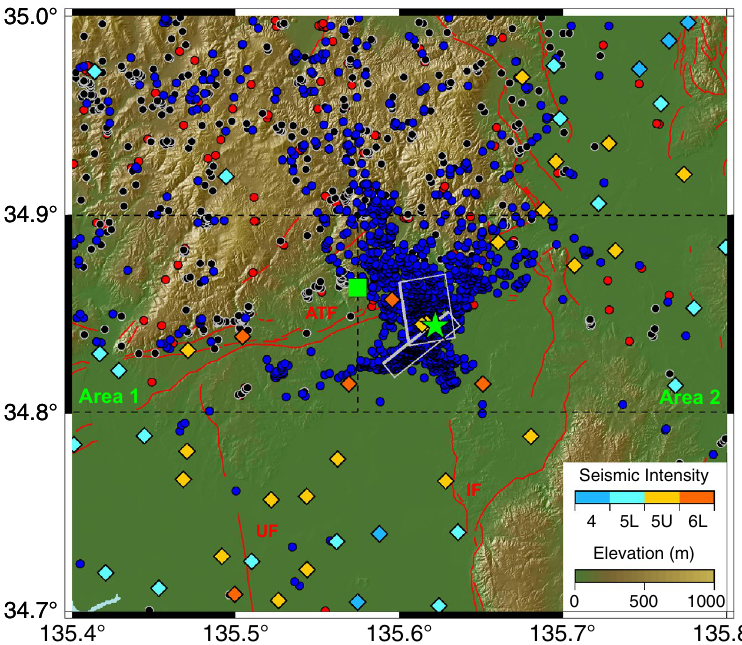
Figure 1. Map of the seismic sequence of the 2018 Northern Osaka earthquake in Japan ( M j 6.1). Green star and square show the epicentre of the mainshock and the radon monitoring site (Osaka Medical and Pharmaceutical University, OMPU), respectively. Black, red, and blue solid circles indicate earthquakes > M j 1.0, focal depth < 30 km in the normal (from March 2014 to February 2017), preseismic (from March 2017 to the main shock on 18 June 2018), and postseismic (aftershock, from 18 June 2018 to 31 July 2020) periods, respectively. Diamond symbols indicate seismic intensities at the moment of the mainshock 42 . Grey rectangles indicate source faults 40 . Red lines indicate active faults 43 : ATF Arima–Takatsuki Fault, IF Ikoma Fault, UF Uemachi Fault. The figure is drawn by Generic Mapping Tool 44 (version 5.4.5, http:// gmt. soest. hawaii. edu/ doc/5. 4.5/ index.